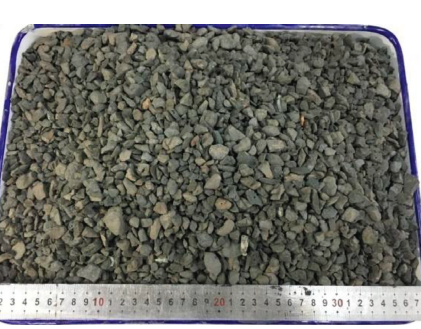
Figure 1: Crushed shale